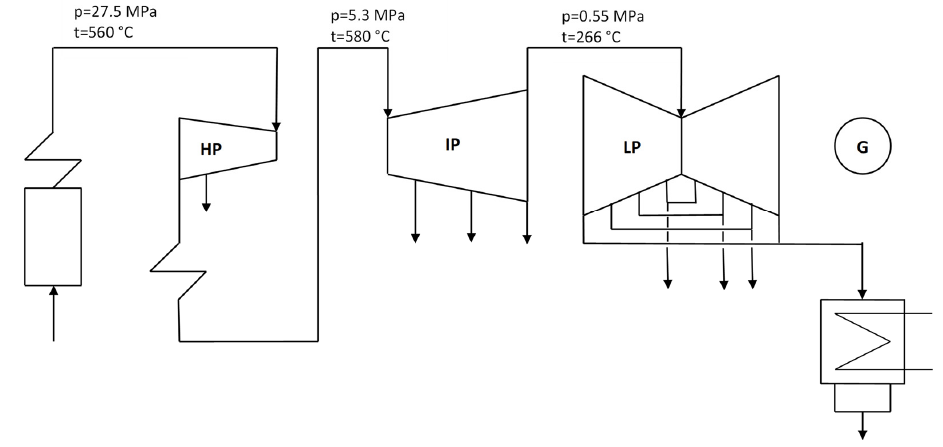
Figure 2. Diagram of the 460 MW condensing turbine (HP—the high-pressure section of the turbine, LP—the intermediate-pressure section of the turbine, LP—the low-pressure section of the